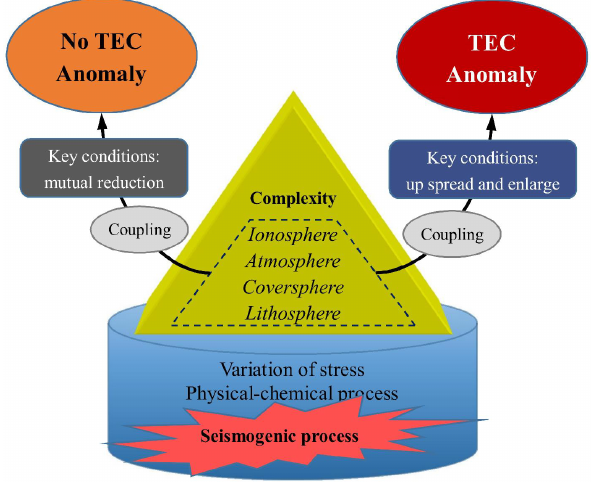
Fig. 8. Schematic plot for interpreting whether the TEC anomalies Figure 8. Schematic plot for interpreting whether the TEC anomalies are generated by are generated by earthquakes.